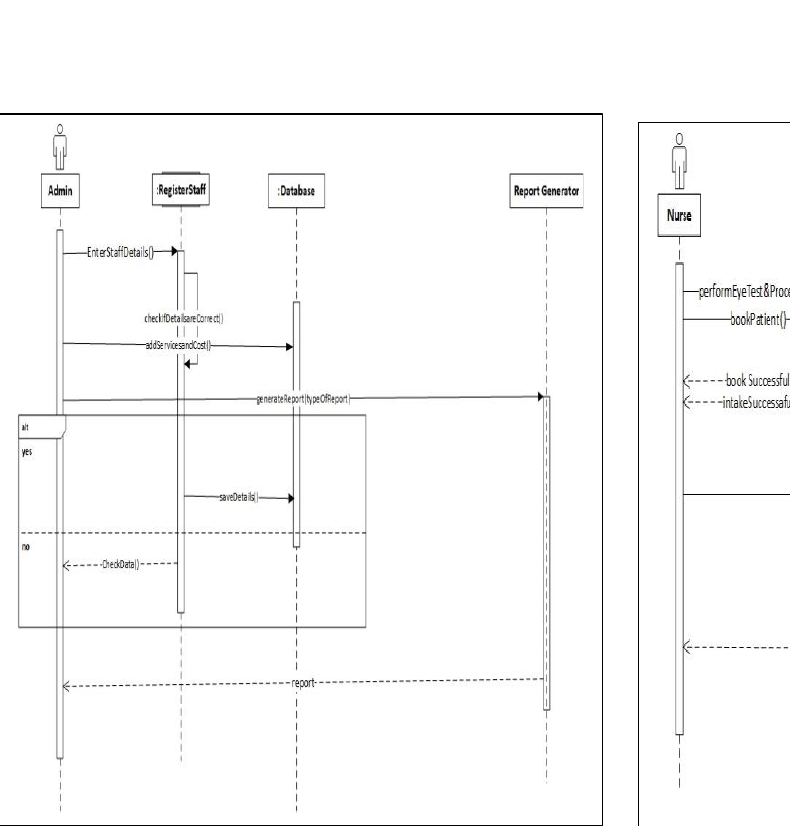
Figure 7. Administrator Sequence Diagram